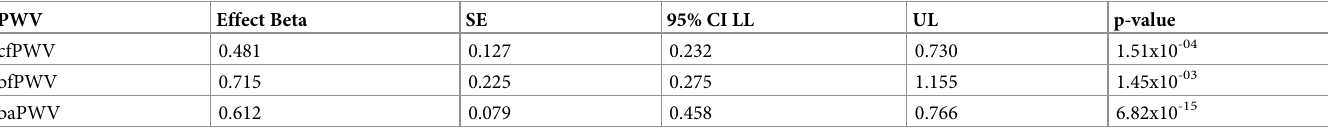
Table 4. Results of Mendelian Randomization analysis. Inverse-variance weighted method was used to combine the evidence of multiple instruments (variants uncorre- lated, random-effect model).